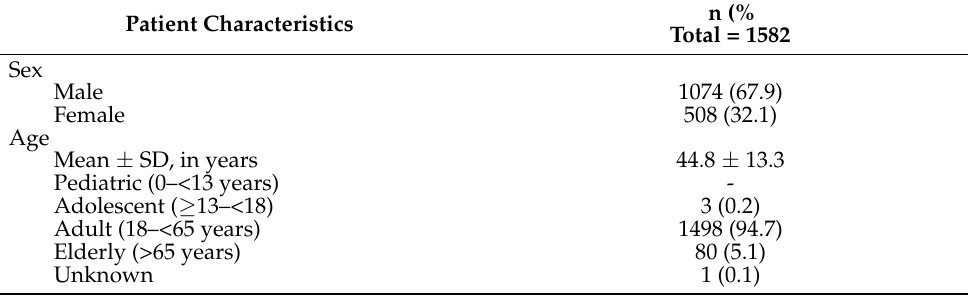
Table 3. Characteristics of patients for opioid-related deaths in Quebec (Coroner’s reports) (2009–2019).